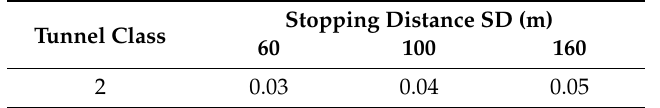
Table 6. Recommended values of k factor for di ff erent values of stopping distance (SD) for tunnel class 2 (motorized tra ffi c only and medium tra ffi c flow) using the tra ffi c weighed method